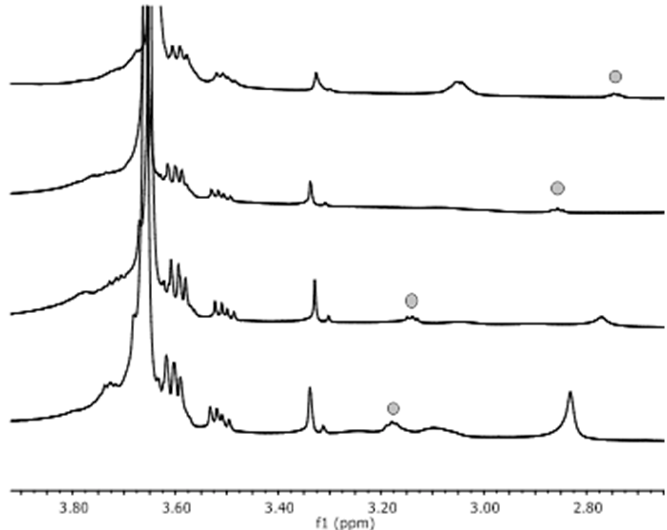
Figure 2. 1D NMR spectra recorded with the sequence noesypr1d on water suspensions prepared with 10% D 2 O of the silica NP grafted with PEG at different pH: from the bottom to the top, the pH is equal to 6, 9, 10.5 and 12.